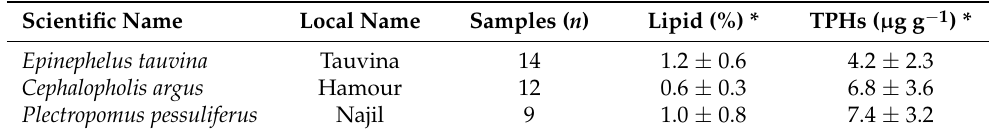
Table 5. TPHs concentration and lipid content in fish species.